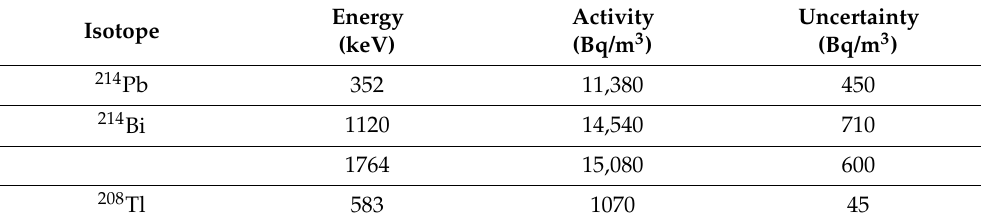
Figure 3. The gamma-ray spectrum acquired during the first day of the experiment in the calibration tank. Table 1. The quantitative data of the radon and thoron progenies in the water